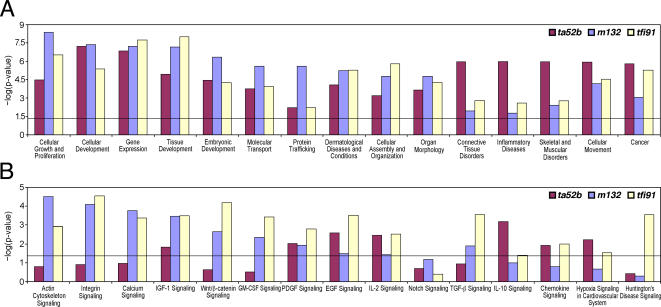
Significantly up-regulated and down-regulated genes analyzed by IPA (see Materials and Methods) for (A) enrichment of functional groups and (B) enrichment of canonical pathways, shown in histograms.